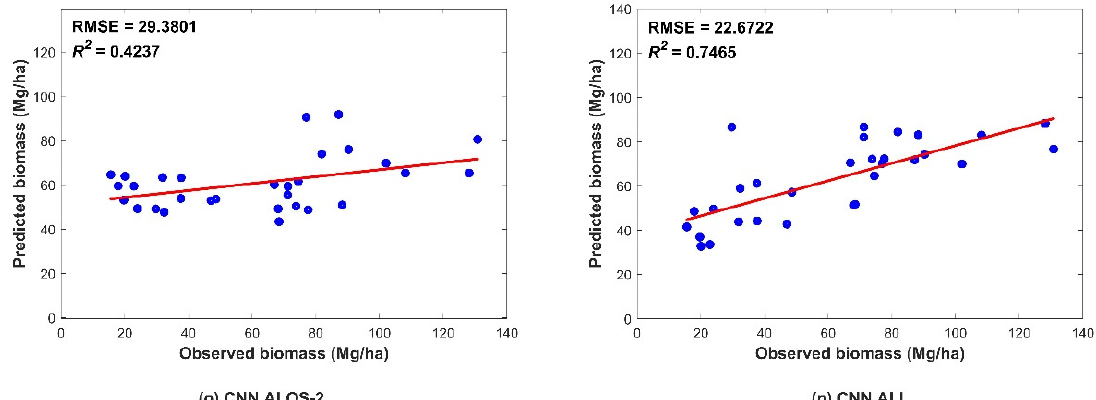
Figure 5. Scatter plots showing the predicted and observed AGB obtained from data validation using the four models. The figures depict the different predictors, including ( a , e , i , m ) Sentinel-2 data; ( b , f , j , n ) Sentinel-1 data; ( c , g , k , o ) ALOS-2 data; and ( d , h , l , p ) combination of all three datasets. The blue dots indicate a pair of corresponding predicted and observed values. The red line indicates the trend line.